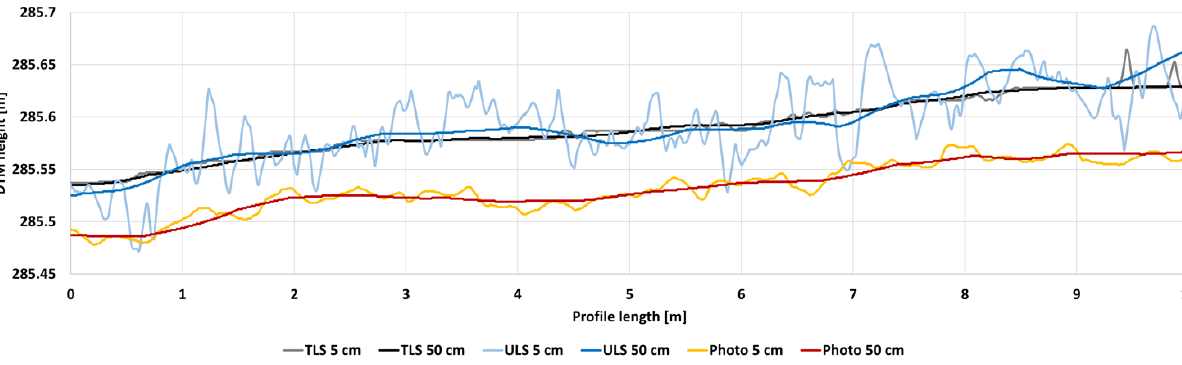
Figure 8 . Example of DTM cross-sections for the data collected in 2019.